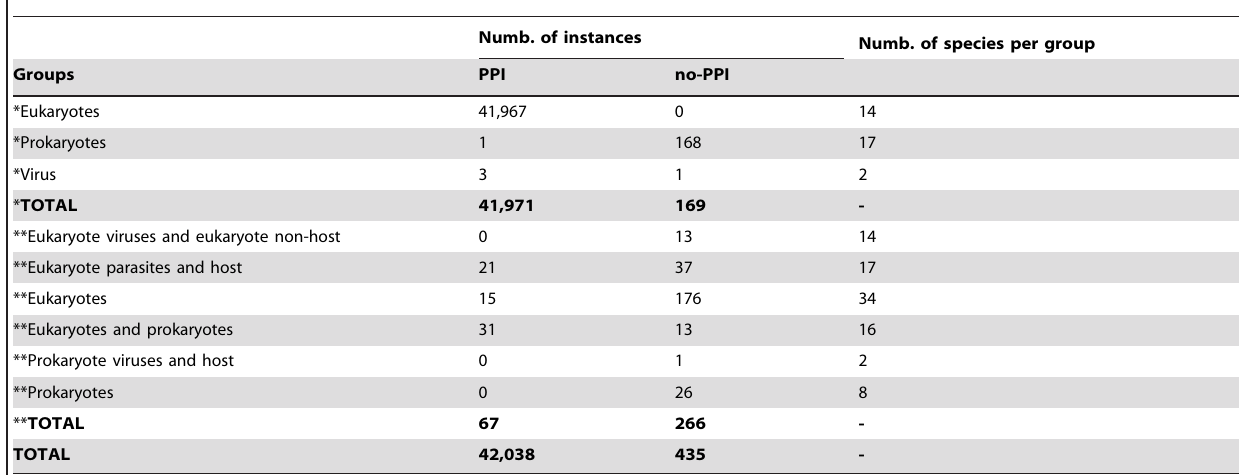
Table 5. Descriptions of instances inserted in the test set.